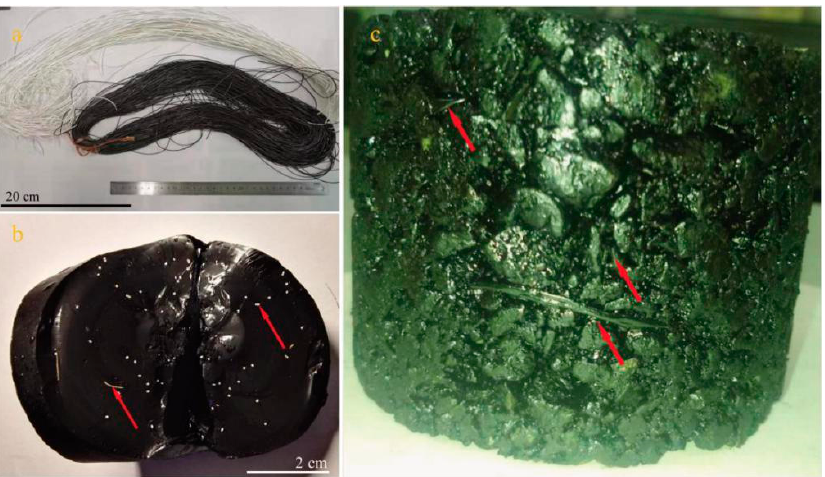
Figure 3. Photographs of microvasculars in asphalt sample, ( a ) microvascular without (white) or with (black) oily rejuvenator, ( b ) interface morphology of broken bitumen sample with microvasculars without oily rejuvenator, and ( c ) asphalt sample with microvasculars with rejuvenator.